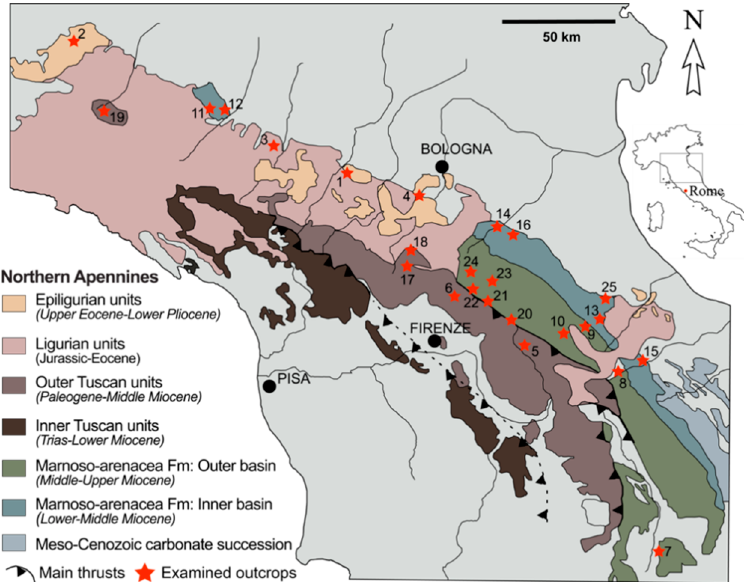
Figure 1. Simplified geological map of the studied area in the northern Apennines. Numbers refer to the examined and correlatable outcrops. 1. Montebaranzone; 2. Cappella Moma; 3. Traversetolo; 4. Lavino Valley; 5. Moggiona; 6. Fosso Riconi; 7. Deruta; 8. Poggio Campane; 9. S. Sofia-S. Vernicio; 10. S. Sofia-Case Buscarelle; 11. Salsomaggiore-Case Gallo; 12. Salsomaggiore-Case